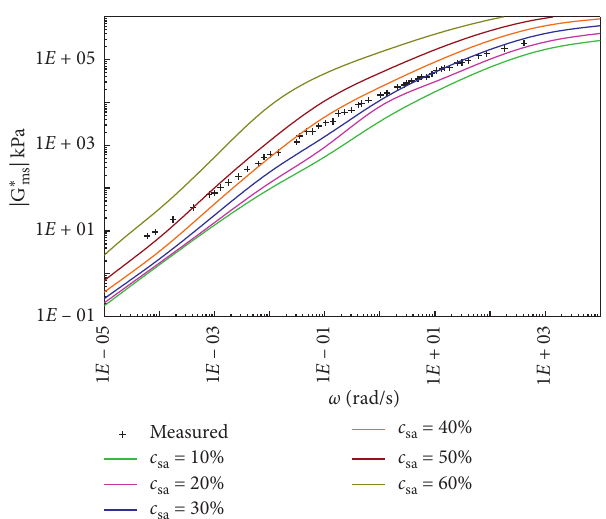
Figure 8: Effect of structural asphalt volume fraction on the prediction modulus of MS30.